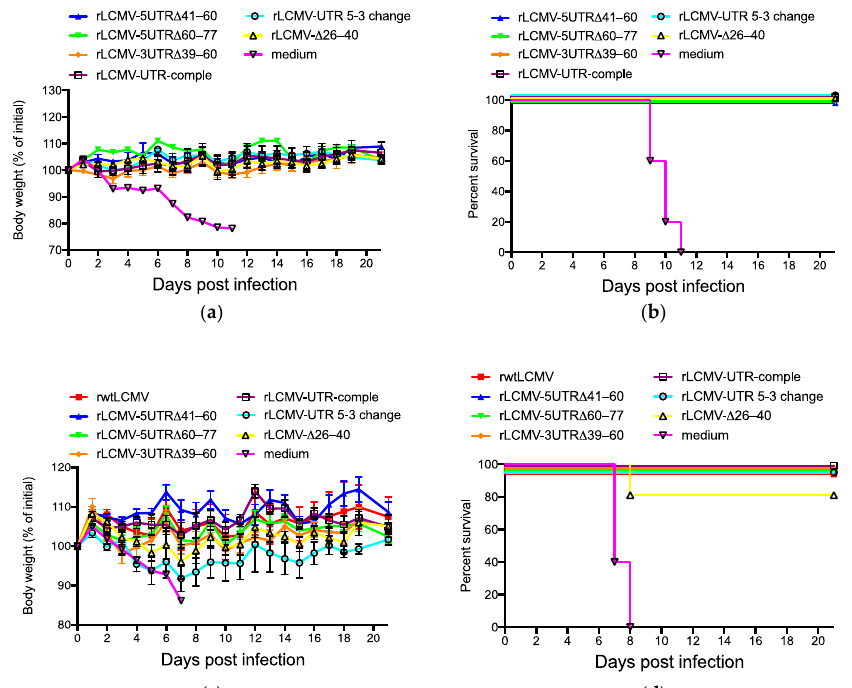
Figure 5. Mice previously infected with rLCMVs were given a lethal dose infection of wtLCMV. Mice that survived inoculation with rLCMVs were further infected intraperitoneally (i.p.) with 1.0 × 10 3 FFU of wtLCMV 40 days after the first inoculation. ( a , b ) Changes in body weight and survival rate of CBA/NSlc mice: CBA/NSlc mice previously inoculated with rLCMV-5UTR ∆ 41–60 (3 mice per group), rLCMV-5UTR ∆ 60–77 (1 mouse per group), rLCMV-3UTR ∆ 39–60 (5 mice per group), rLCMV-UTR-comple (5 mice per group), rLCMV-UTR 5-3 change (5 mice per group), rLCMV- ∆ 26–40 (5 mice per group), or medium (5 mice per group) were used. ( c , d ) Changes in body weight and survival rate of DBA/1JJmsSlc mice: DBA/1JJmsSlc mice previously inoculated with rwtLCMV (3 mice per group), rLCMV-5UTR ∆ 41–60 (5 mice per group), rLCMV-5UTR ∆ 60–77 (5 mouse per group), rLCMV-